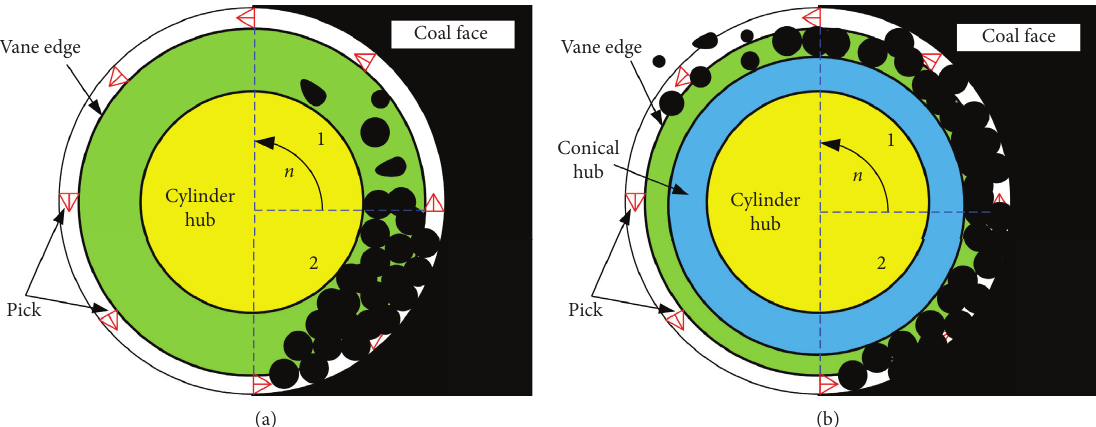
Figure 10: Schematic diagram of the influence of the drum space capacity on the coal conveying performance: (a) the coal conveying process with the cylinder hub drum; (b) the coal conveying process with the conical hub